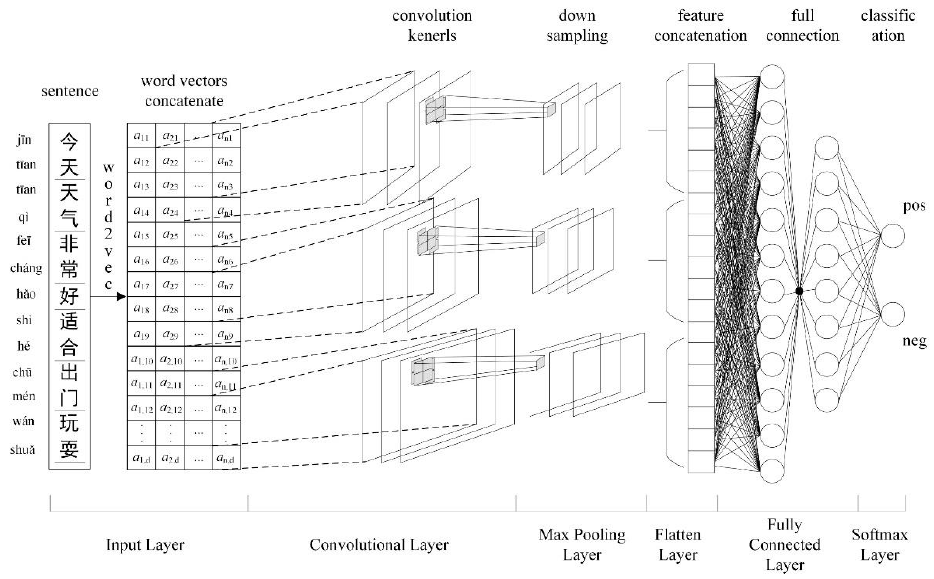
Figure 4. Architecture of the deep learning model.